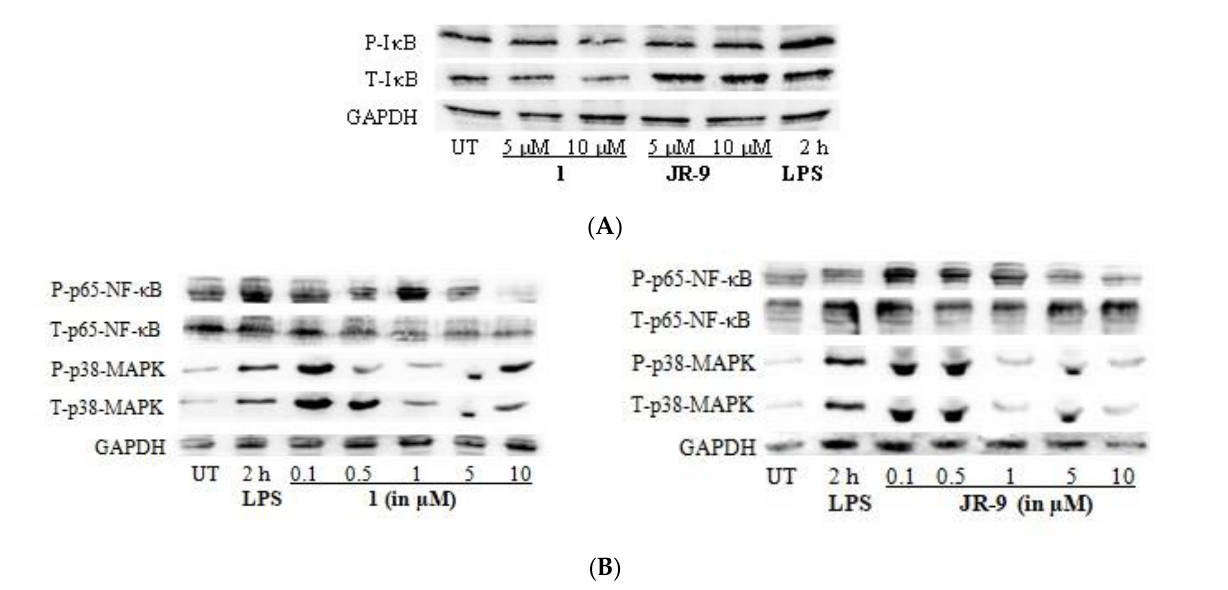
Figure 6. ( A ) Impact of 1 and JR-9 on the P-I κ B and T-I κ B pathway in RAW 264.7 cells. LPS-induced RAW 264.7 cells were treated with 1 and JR-9 for 2 h in different concentrations. The NF- κ B and MAPK signaling pathway expression proteins were detected using Western blotting. ( B ) Impact of 1 and JR-9 on the NF- κ B and MAPK pathway in RAW 264.7 cells. LPS-induced RAW 264.7 cells were treated with 1 and JR-9 for 2 h in different concentrations. The NF- κ B and MAPK signaling pathway expression proteins were detected using Western